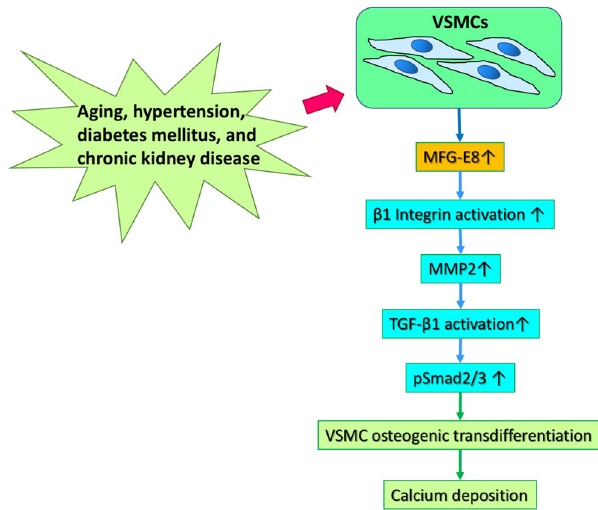
Fig. 8 Proposed model in which milk fat globule – epidermal growth factor 8 (MFG-E8) promotes vascular smooth muscle cell (VSMC) osteogenic transdifferentiation and vascular calci fi cation by activating